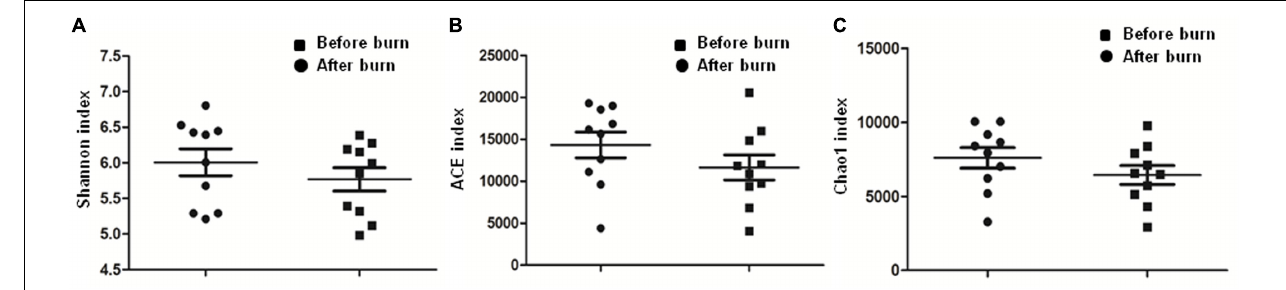
FIGURE 2 | Comparison of Shannon index (A) , ACE index (B) , and Chao 1 index (C) . Paired student’s t -test was used for the statistical analysis and the p -value for each comparison is 0.3038, 0.0606, and 0.0619, respectively.